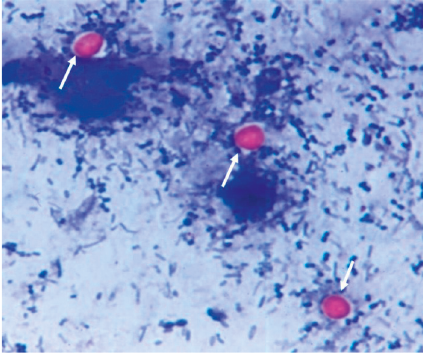
Figure 2: Oocyst of Cryptosporidium sp. (arrows) 100x stained using modified Ziehl–Neelsen stain. Table 1: Detection of Cryptosporidium sp. using modified Ziehl–Neelsen staining of samples that have been collected and prevalence of Cryptosporidium sp., in calves among